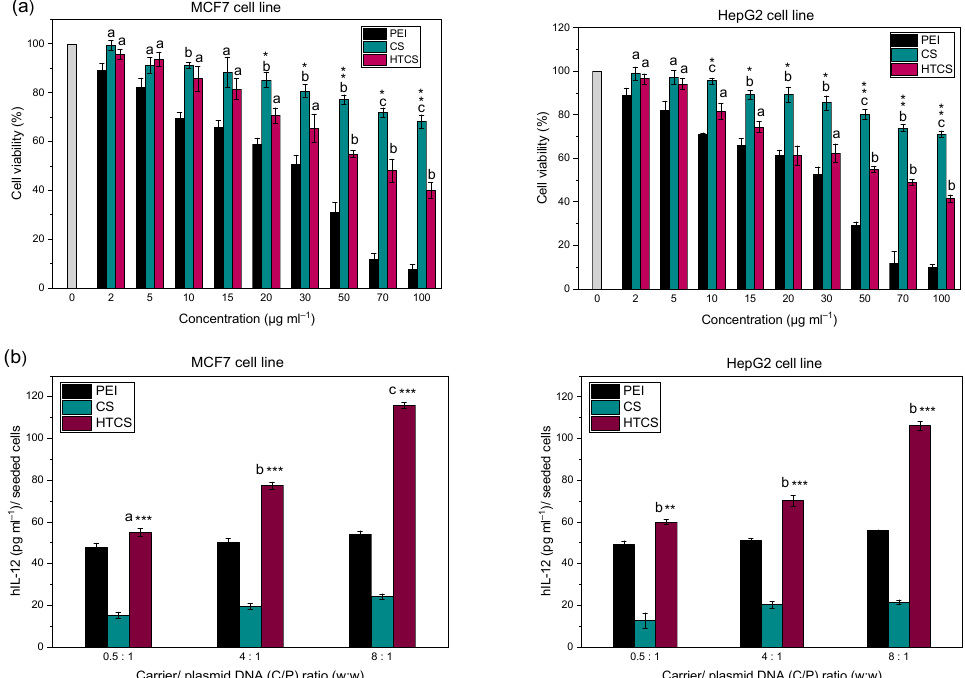
Figure 6. ( a ) Cell viability of MCF-7 and HepG2 cells as a function of concentration of PEI, CS, and HTCS in the medium. a p < 0.05, CS and HTCS compared with PEI at the same concentration; b p < 0.01, CS and HTCS compared with PEI at the same concentration; c p < 0.001, CS and HTCS com- pared with PEI at the same concentration. * p < 0.05, HTCS compared with CS at the same concen- tration; ** p < 0.01, HTCS compared with CS at the same concentration; *** p < 0.001, HTCS com- pared with CS at the same concentration. ( b ) Gene transfer ability of PEI, CS, and HTCS. The levels of hIL-12 in MCF-7 cells and HepG2 cell following treatment with polyplexes at C/P ratios of 0.5, 4, and 8. The level of hIL-12 expression is presented as the concentration of the protein (pg ‧ mL –1 ) per seeded cell. a p < 0.05, CS and HTCS compared with PEI at the same C/P ratio; b p < 0.01, CS and HTCS compared with PEI at the same C/P ratio; c p < 0.001, CS and HTCS compared with PEI at the same C/P ratio. * p < 0.05, HTCS compared with CS at the same C/P ratio; ** p < 0.01, HTCS com- pared with CS at the same C/P ratio; *** p < 0.001, HTCS compared to CS at the same C/P ratio.